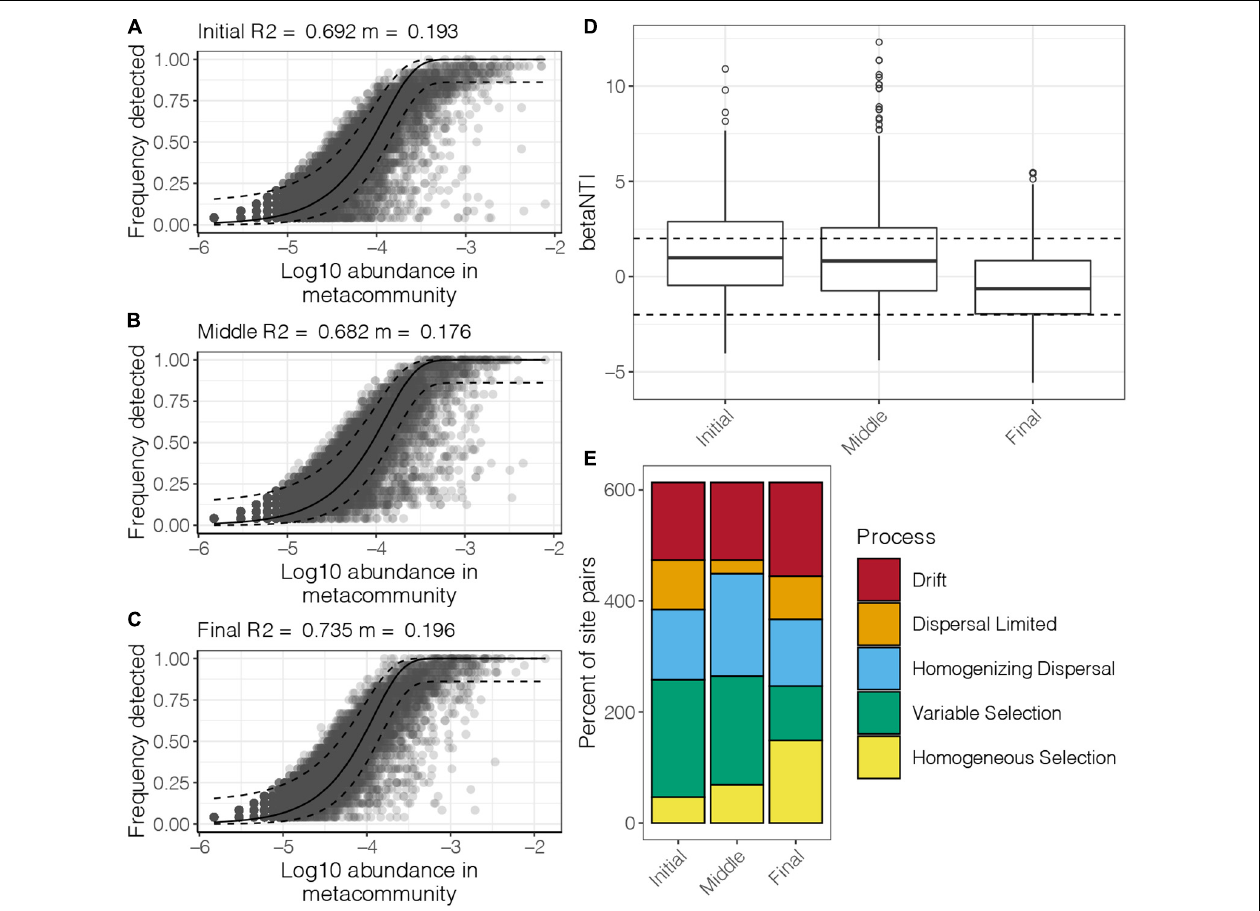
FIGURE 5 | Fit of the NCM for benthic bacterial communities in the purification area of the IPRS at the (A) initial, (B) middle, and (C) final stages of the culture cycle. The solid and dashed lines indicate the best fit to the NCM and 95% confidence intervals around the model prediction, respectively. m indicates the meta-community size times immigration, and R 2 indicates the fit to this model. (D) Distribution of the β NTI of the benthic bacterial communities in the purification area of the IPRS at different culture stages. (E) Comparison of the contribution of the ecological processes that determine community structure of benthic bacterial communities in the purification area of the IPRS at different culture